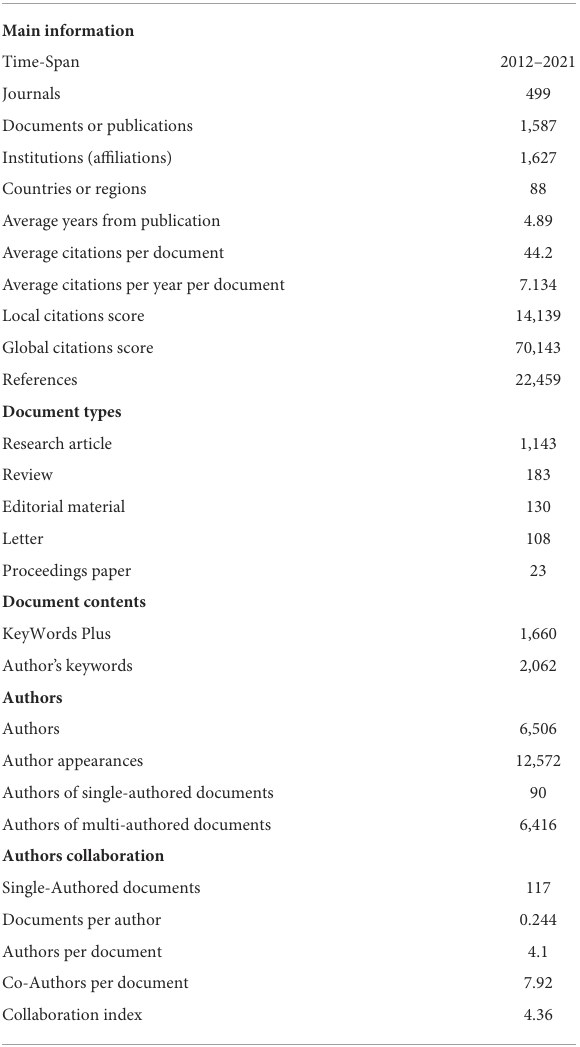
TABLE 1 Main information about the included and analyzed publications on MERS-CoV between 2012 and 2021.